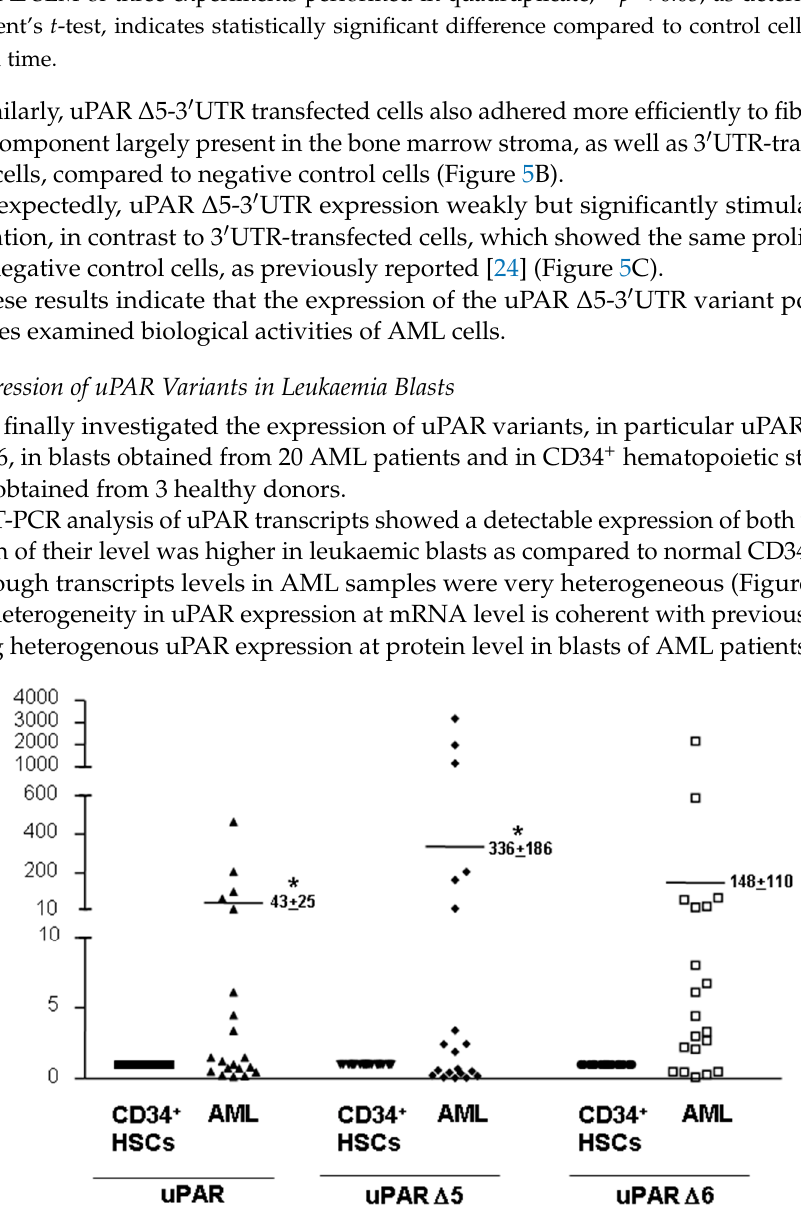
Figure 6. Expression of uPAR variants in leukaemia blasts. CD34 + hematopoietic stem cells (HSCs) from 3 healthy donors and blasts from 20 patients affected by acute myeloid leukaemia (AML) were lysed in QIAzol and analysed by qRT-PCR with uPAR, uPAR ∆ 5 or uPAR ∆ 6 specific primers. Results are expressed as fold change of uPAR expression in AML blasts relative to CD34 + HSCs. The relative level of expression was calculated with the formula 2 −ΔΔ CT . Values are the mean ± SEM of three experiments performed in triplicate; * p < 0.05 as determined by Student’s t -test. These results demonstrate that uPAR variants detected in AML cell lines are expressed also in vivo in AML